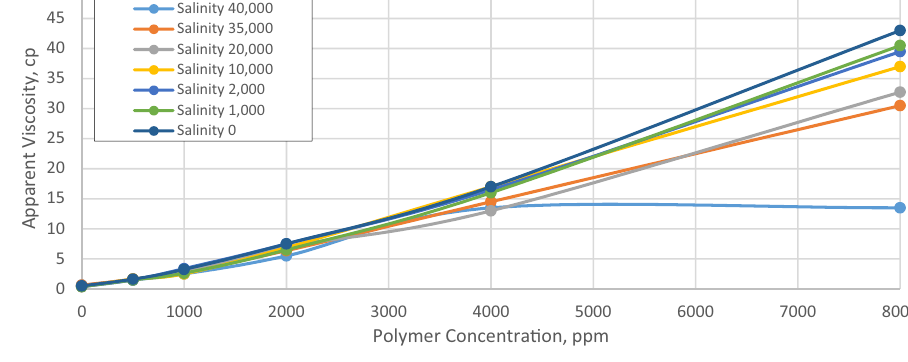
Fig. 7 Apparent viscosity plot for refined xanthan gum with 35,000 ppm and 2000 ppm NaCl at varying